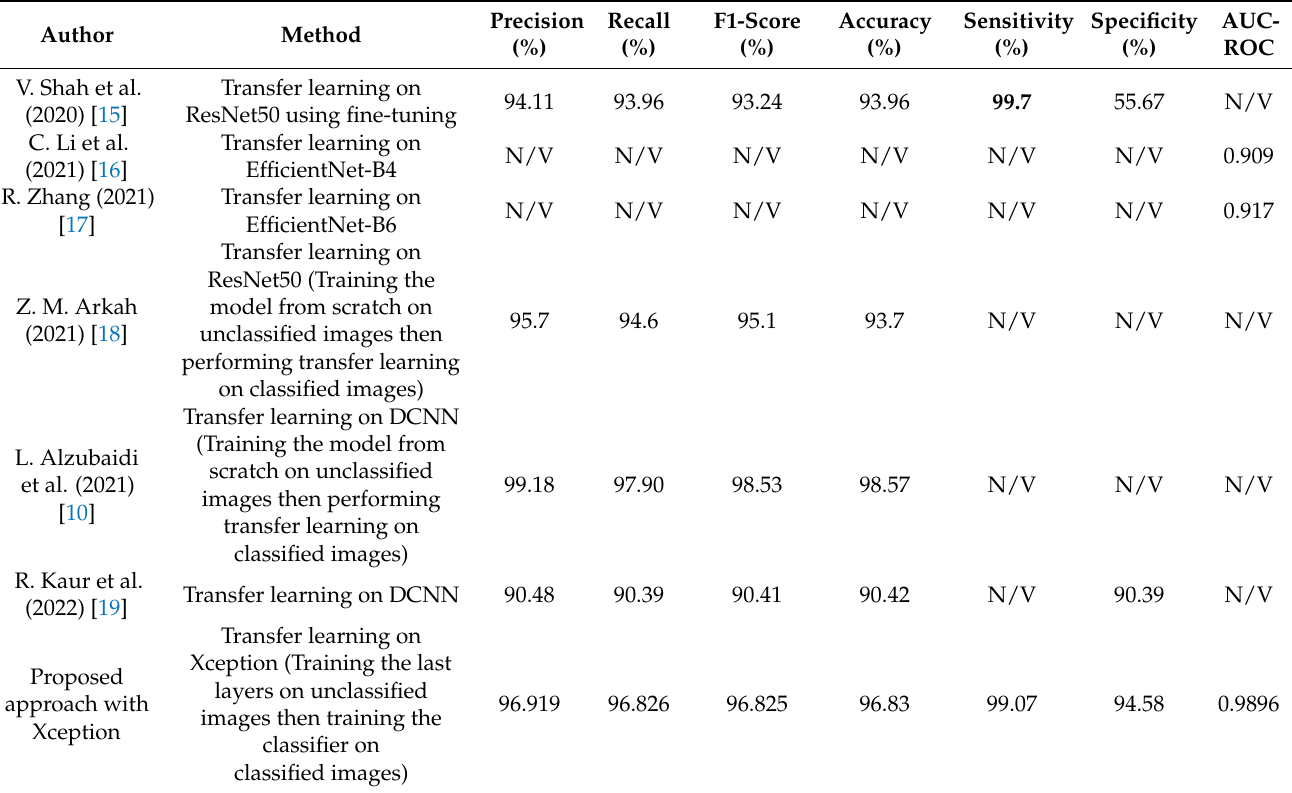
Table 8. Comparison of the results of the proposed approach with related works for the classification of skin cancer images in the ISIC2020